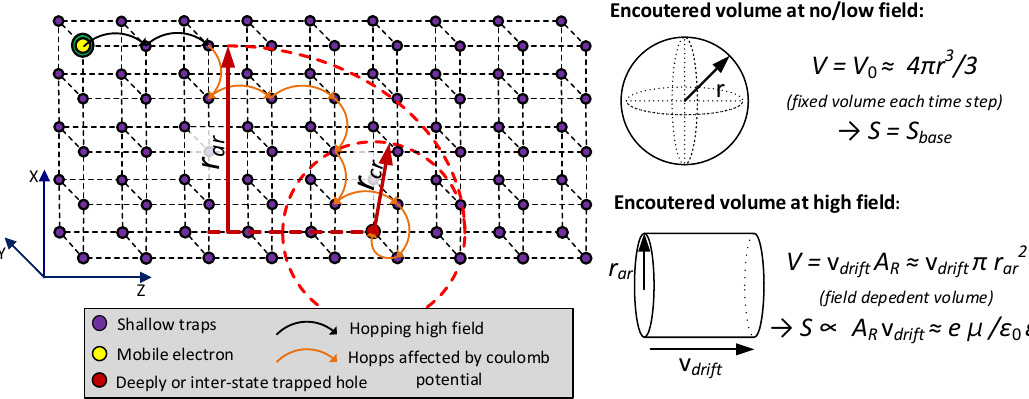
Figure 5. Charge recombination scheme (mobile electron–trapped hole) assuming similar charge movement patterns to the trapping process (Figure 3), but with the added effect of local coulombic interaction between the participating charge carriers. Shallow traps are assumed to be uniformly spread with a cubic lattice.